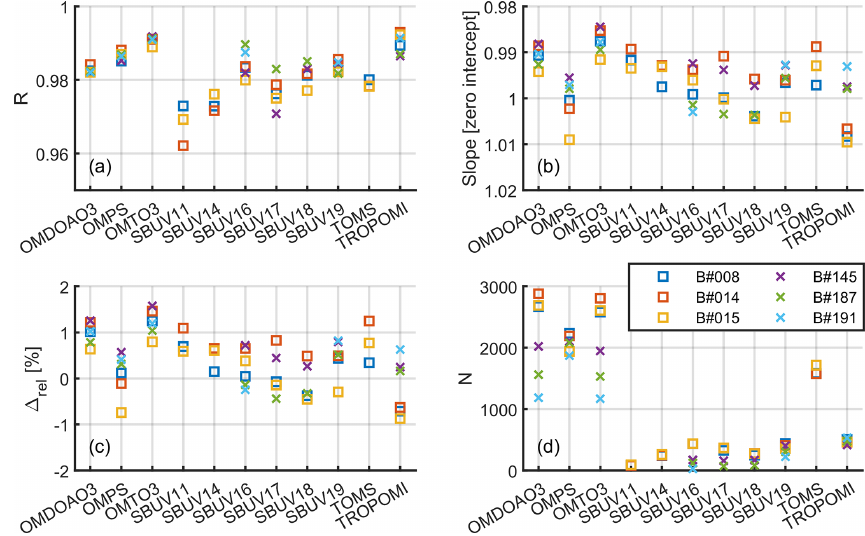
Figure 7. Summary of the regression analysis between satellites and the world Brewer reference triads. The four panels represent the (a) correlation coefficient ( R ) between individual Brewer instruments and different satellites (labelled at the bottom axis), (b) the slope of the zero intercept regression line (multiplicative bias), (c) relative percentage difference (bias), and (d) the total number of coincident observations.